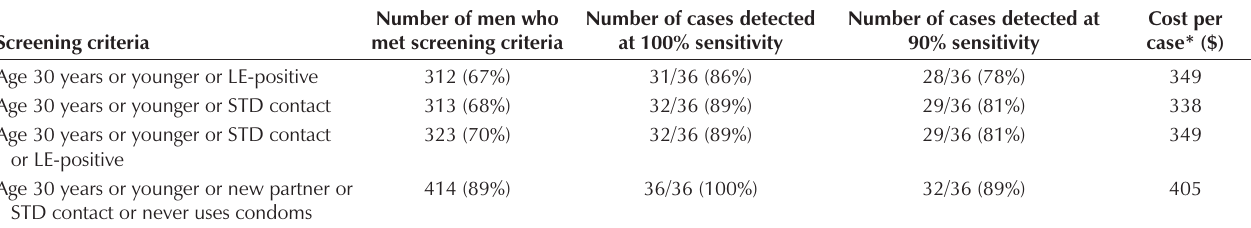
TABLE 4 Cost of different screening strategies for men younger than age 30 years attending a sexually transmitted disease (STD) clinic Screening criteria